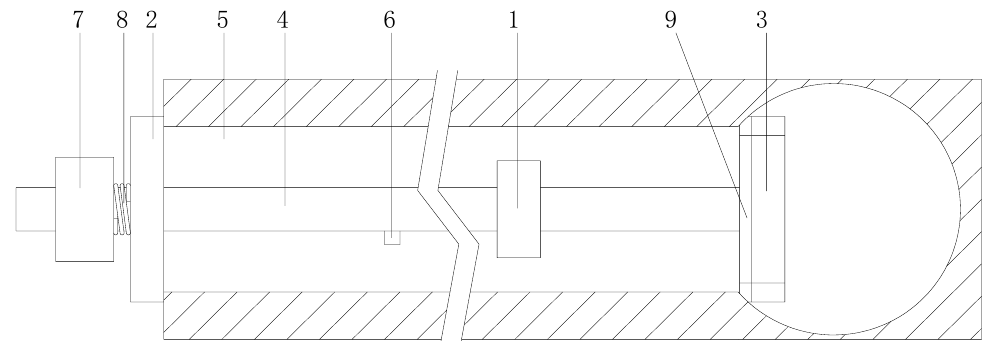
Figure 11. Schematic diagram of ultrasonic resonance treatment device for crystal blockage of transverse drainage pipe of Metro Tunnel.